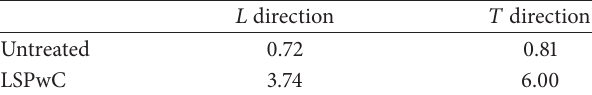
Table 2: Surface roughness results. 𝐿